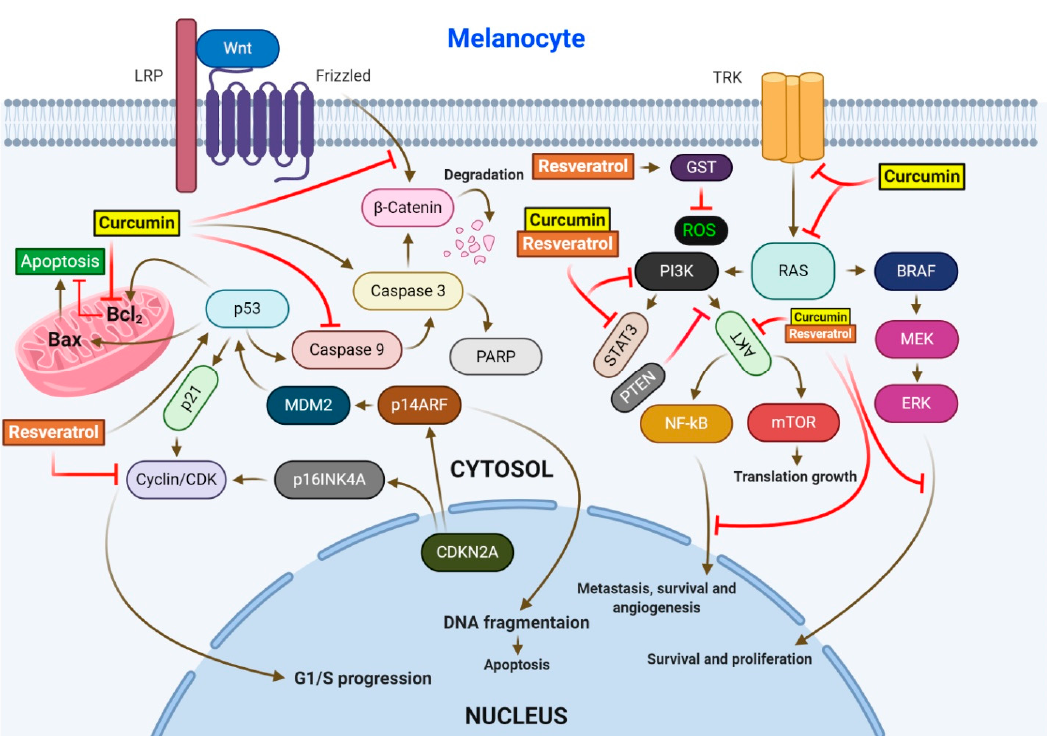
Figure 3. Regulation of the major cell signaling pathways by resveratrol and/or curcumin in melanoma. The four pathways regulated by these drugs include MAPK, PI3K/AKT, WNT/ β -catenin, and the CDKN2/CDK4 tumor-suppressive pathway. Upon activation, these pathways lead to apoptosis, survival, proliferation, and angiogenesis.